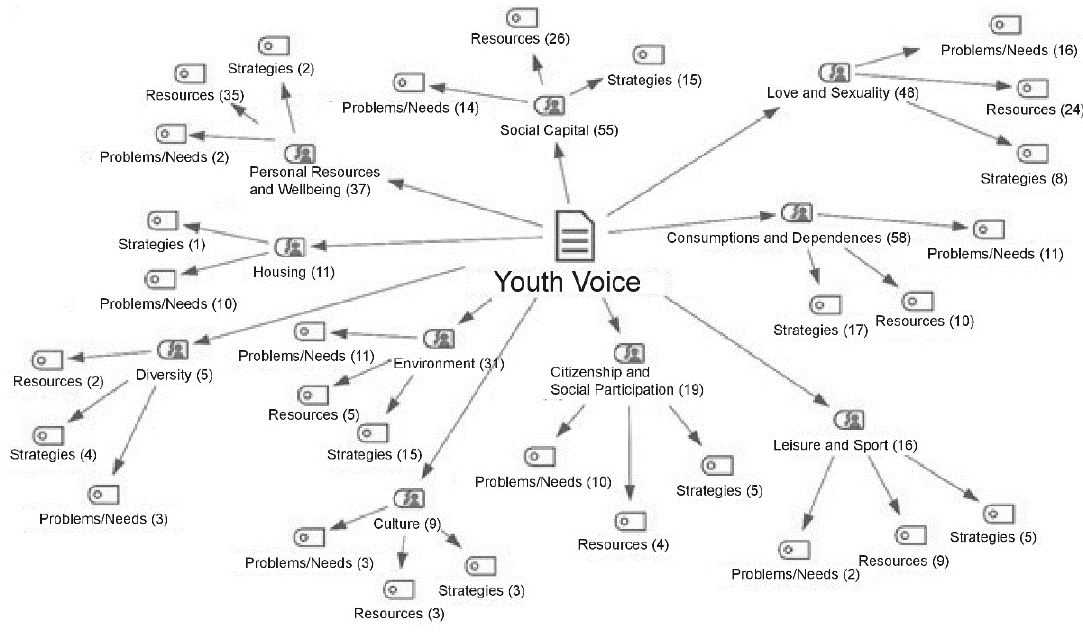
Figure 2. Hierarchy of Codes Model [Reprinted from Branquinho et al., 2021; [32]].